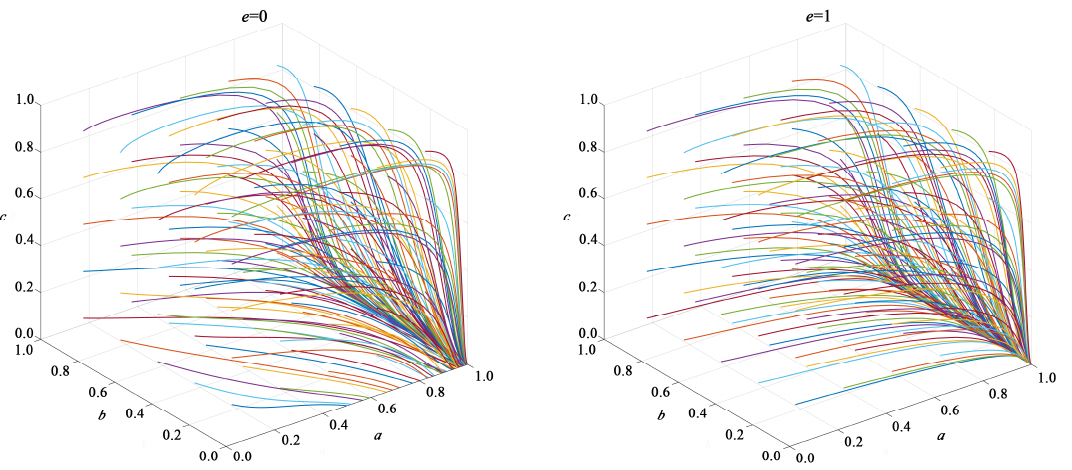
Figure 7. The influence of government’s regulatory system on the other three subjects under policy promotion.